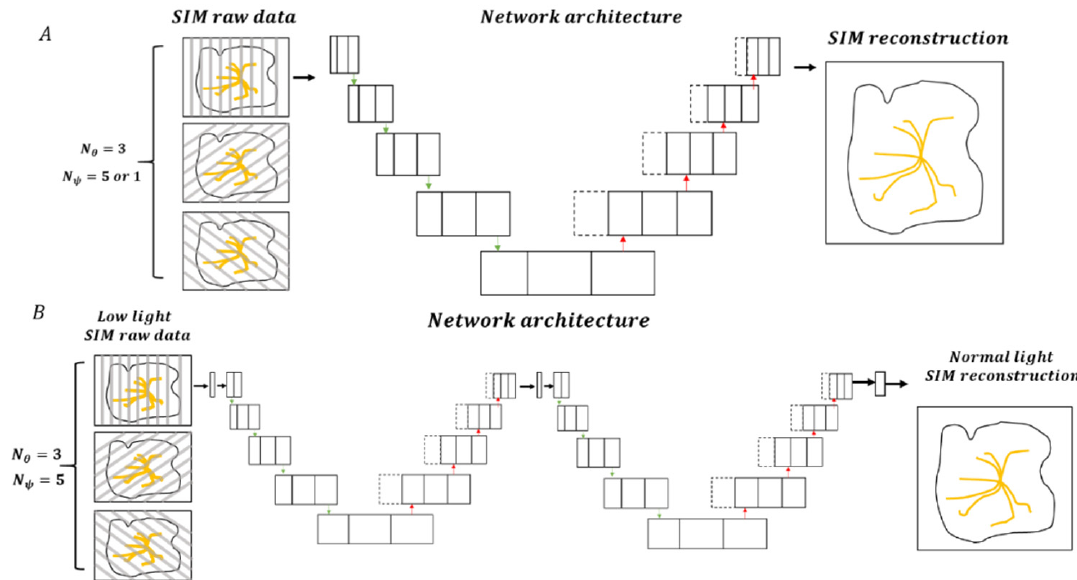
Figure 10. Schematic of U-Net ( A ) and scU-Net ( B ) training methods. Here, 15 or three SIM raw images were used as the U-Net input, and SIM reconstruction using 15 raw images was used as the ground truth. Both the input and ground truth of scU-Net were acquired under low-light conditions.